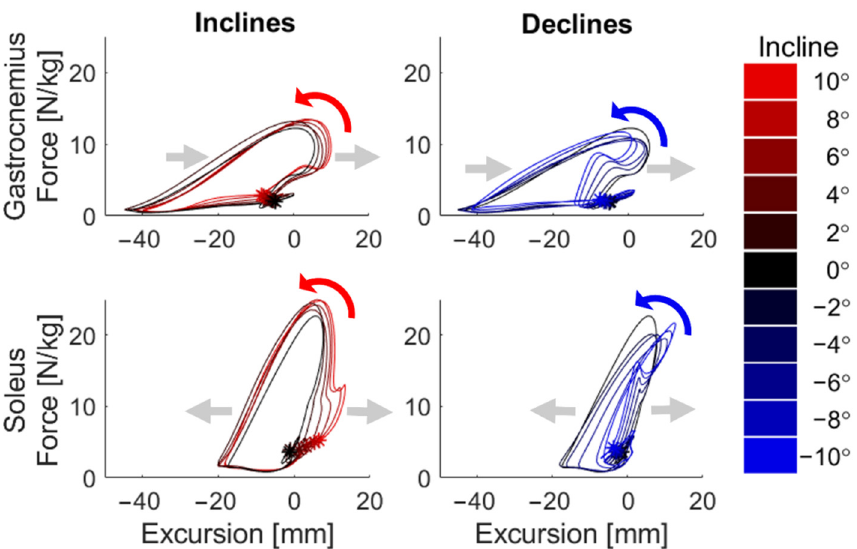
Figure 5. Muscle–tendon work loops, i.e., plots of force vs. excursion of the muscle–tendon length; work is the area within the loop, positive if the loop progresses counter-clockwise. The work loops illustrate increasing work production with increasing incline angle. Gray arrows indicate trends with increasing slope across all slopes, while colored arrows indicate loop progression direction. All loops begin at heel strike, designated by an asterisk, and follow a counter-clockwise direction. Length is presented as “excursion”, representing the change in muscle–tendon length relative to its length in an upright posture.